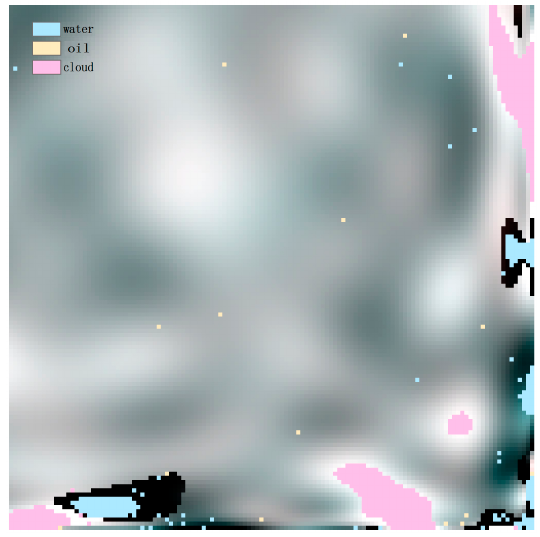
Figure 11. Endmember candidates-spectral purity.